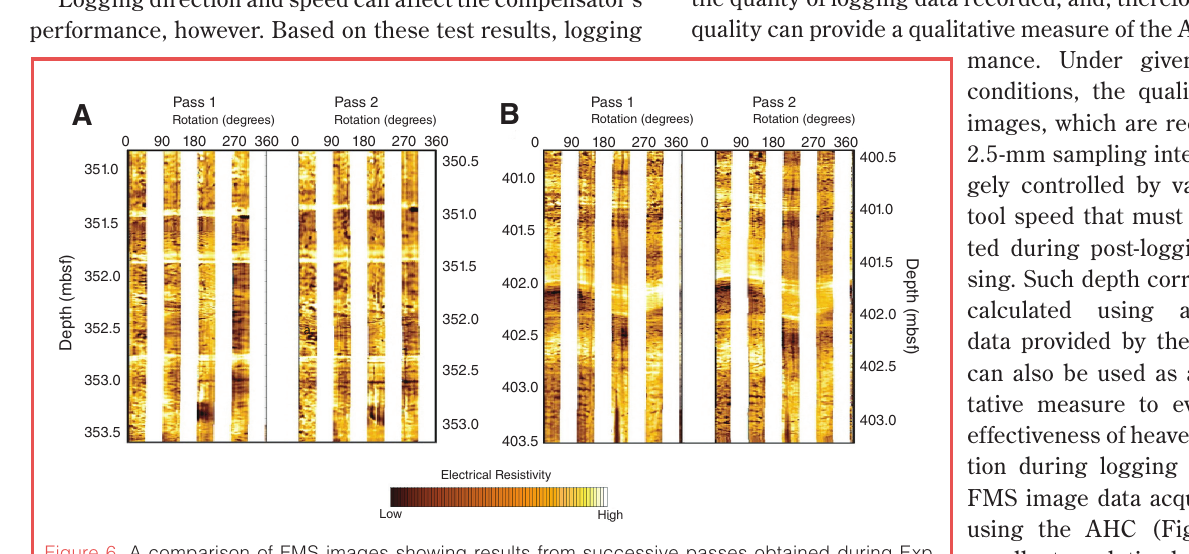
Figure 6. A comparison of FMS images showing results from successive passes obtained during Exp. 320T in Hole U1330A. Passes 1 and 2 show [A] resistive (bright) horizontal layers in thin beds over the lower section of Hole U1330A, and [B] sinusoidal patterns for dipping beds. Depth scale is shown in meters below seafloor or mbsf. Modified from Liu et al.,